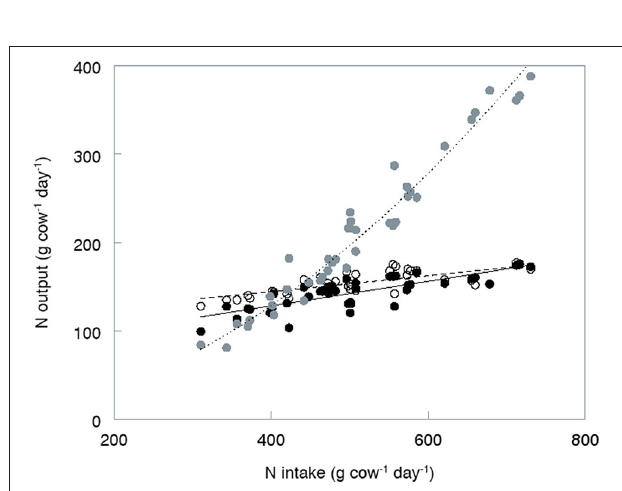
FIGURE 5 | Simulated relation between total nitrogen (N) intake (g day − 1 ) and the output of N (g day − 1 ) with (•) milk ( ◦ ) feces and (•) urine for 40 nutritional